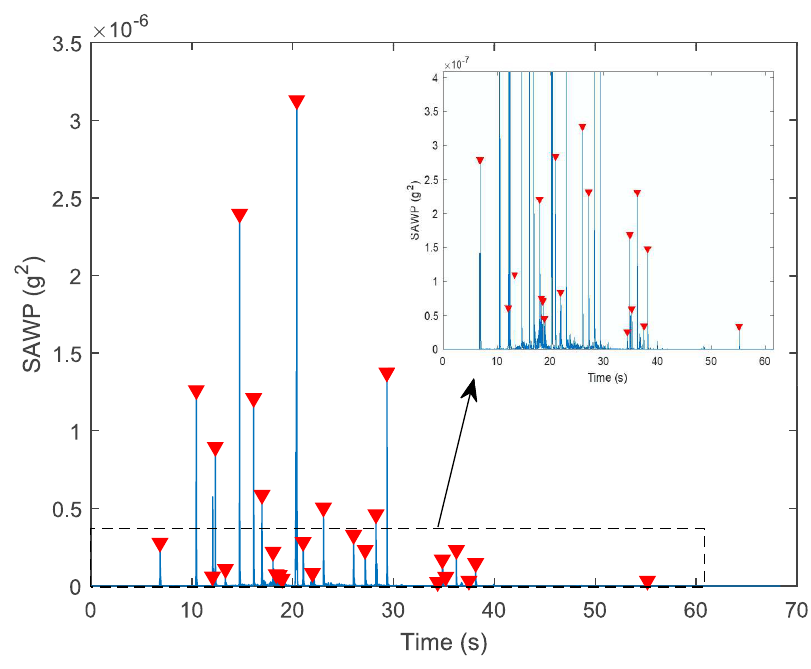
Figure 6. Scale-averaged wavelet power (SAWP) peaks found for a 4 mm squat